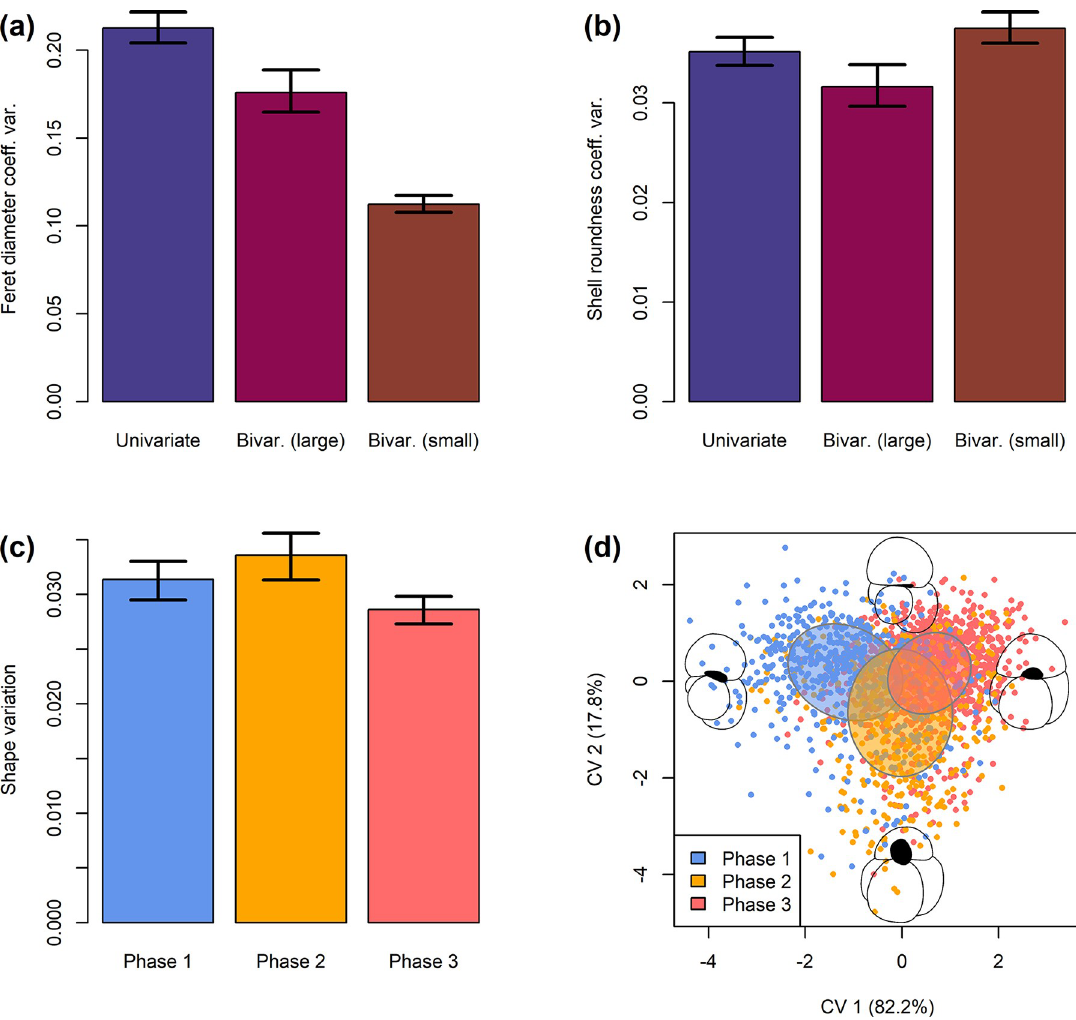
Fig 4. Stabilizing selection in planktonic Foraminifera during marine isotope stage 12 in the Red Sea. (a–b) The variation of shell size and shell roundness (including 95% confidence interval) in the incumbent population of Orbulina universa decreased toward local extinction. The small population had an inherently reduced size variation but higher variation of shell roundness. (c) The shape variation (Riemannian shape distance from the mean shape, excluding sacculifer-morphotype) in Trilobatus sacculifer decreased significantly toward the local extinction (Phase 3, compare Fig 1). Error bars depict the 95% confidence interval. (d) Canonical variates analysis (CVA) of the shape of T . sacculifer (excluding sacculifer-morphotype). Points indicate specimens, ellipses indicate the 95% confidence interval of the standard deviation on the centroid, black silhouettes depict the morphology at the extremal points of the canonical variate (CV) 1 and 2 axes, respectively.